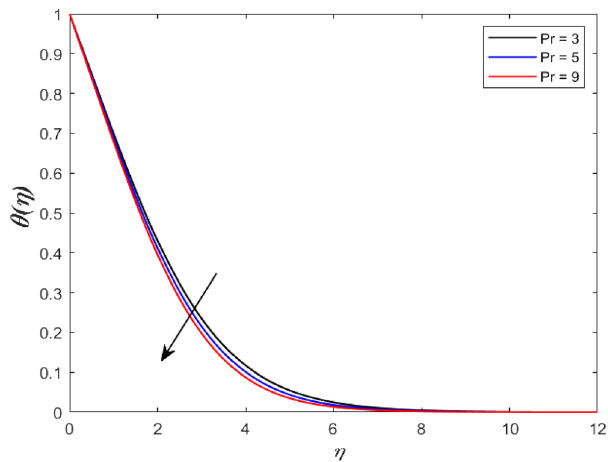
Figure 5. Impact of Pr on temperature outline.